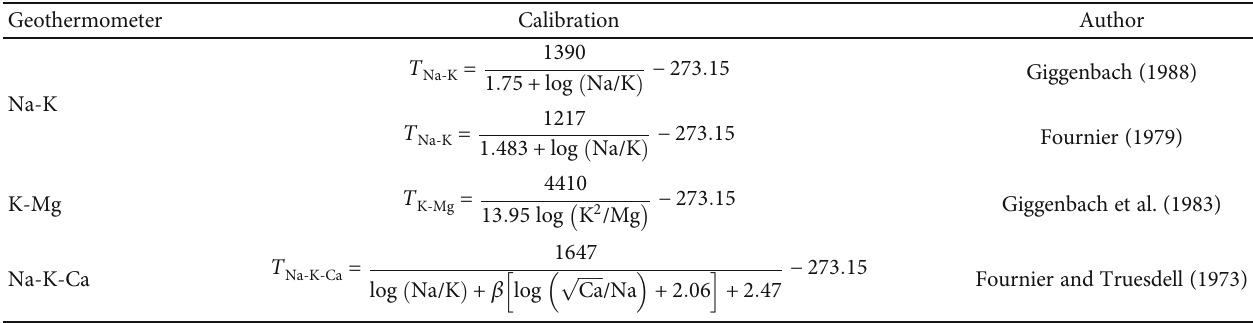
Table 1: Chemical geothermometers used in this work.